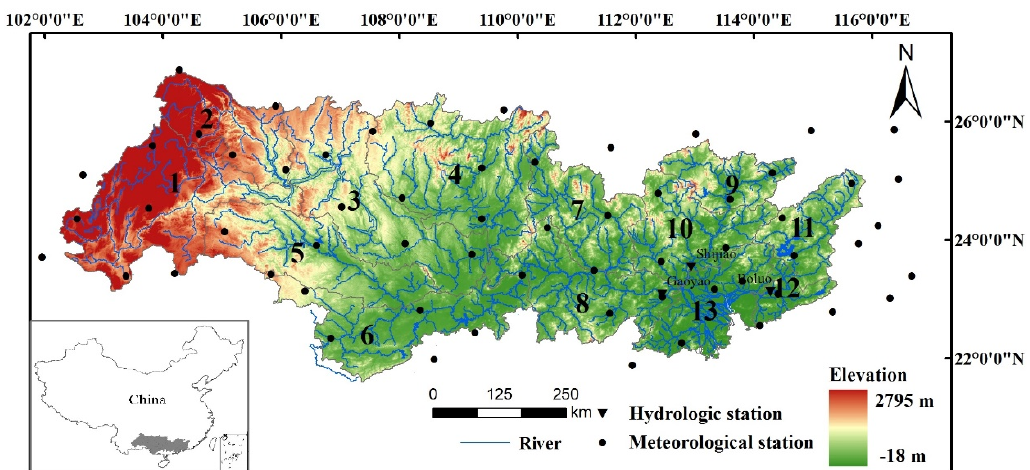
Figure 1. General location of the Pearl River Basin and the sub-regions. Notes: 1: Nanpan River; 2: Beipan River; 3: Hongshui River; 4: Liujiang River; 5: Youjiang River; 6: Zuojiang River and the main stream of the Yujiang River; 7: Hegui River; 8: Qianxun River and Xijiang River; 9: Upstream of the Dakengkou sub-region in the Beijiang River; 10: Downstream of the Dakengkou sub-region in the Beijiang River; 11: Upstream of the Qiujiangkou sub-region in the Dongjiang River; 12: Downstream of the Qiujiangkou sub-region in the Dongjiang River; 13: Pearl River Delta.